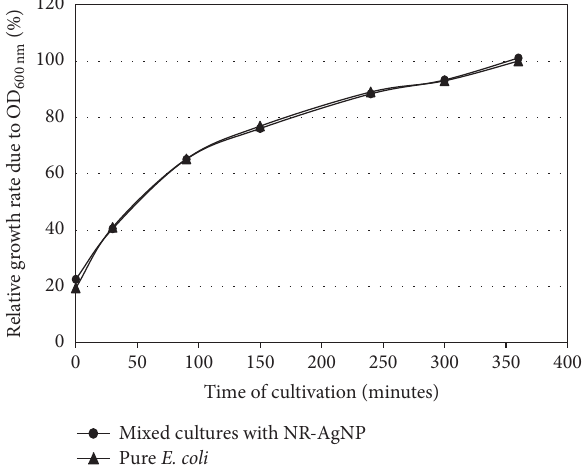
Figure 10: Influence of the NR-AgNP nanocomposites on the growth rate of the E. coli liquid cultures. The data points represent the means of three cultures (standard deviation < 3%).